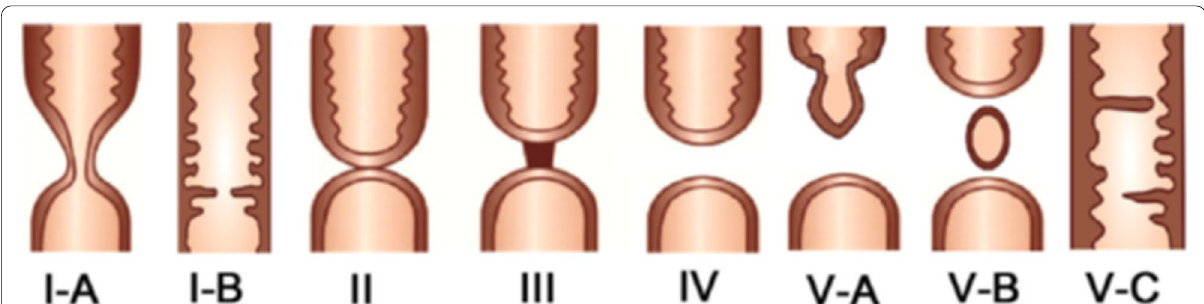
Fig. 4 Adopted from Sharma and Gupta [5]. Classification of rectal atresia. Type I: rectal stenosis: A intramural, B web; type II: rectal atresia with a septal defect; type III: rectal atresia with a fibrous cord between two atretic ends; type IV: rectal atresia with a gap; type V: multiple: A rectal atresia with stenosis, B multiple rectal atresia, and C thickened Houstons valves/multiple rectal